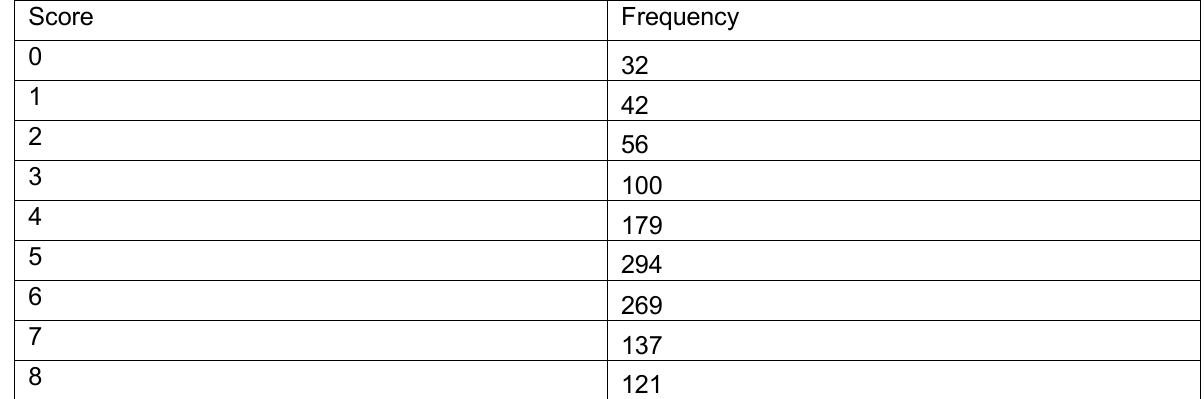
Table 1: Frequency Distribution of The Financial Knowledge